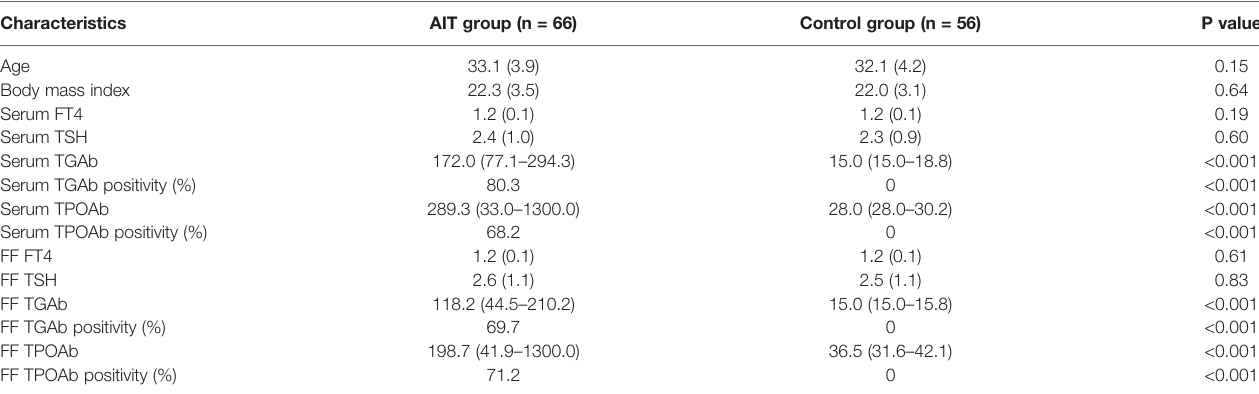
TABLE 1 | Baseline characteristics in patients with and without autoimmune thyroiditis (AIT).